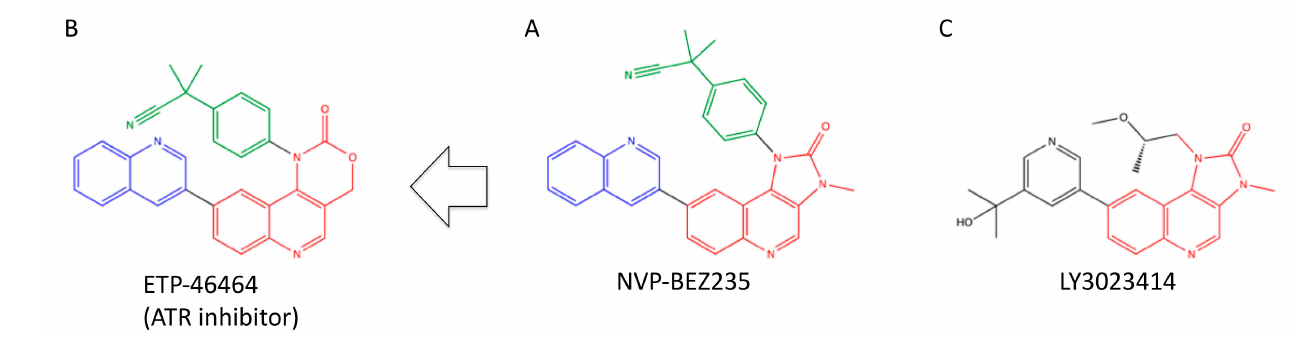
Figure 10. Structures of NVP-BEZ235 ( A ), ETP-46464 ( B ), and LY3023414 ( C ). The imidazoquinoline and oxazinoqinoline structures are highlighted in red. Quinoline and methylphenylpropanenitrile structures, which are common between NVP-BEZ235 and ETP-46464, are highlighted in blue and green,